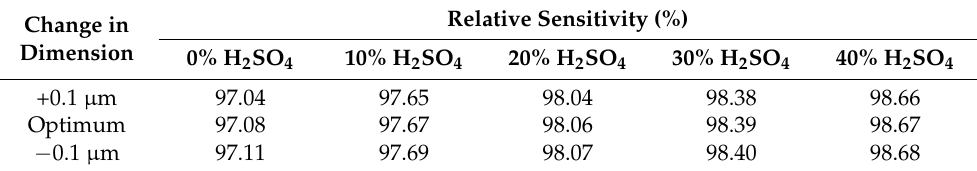
Table 2. Performance analysis against the variation of global dimension at λ = 1.1 µm. Change in